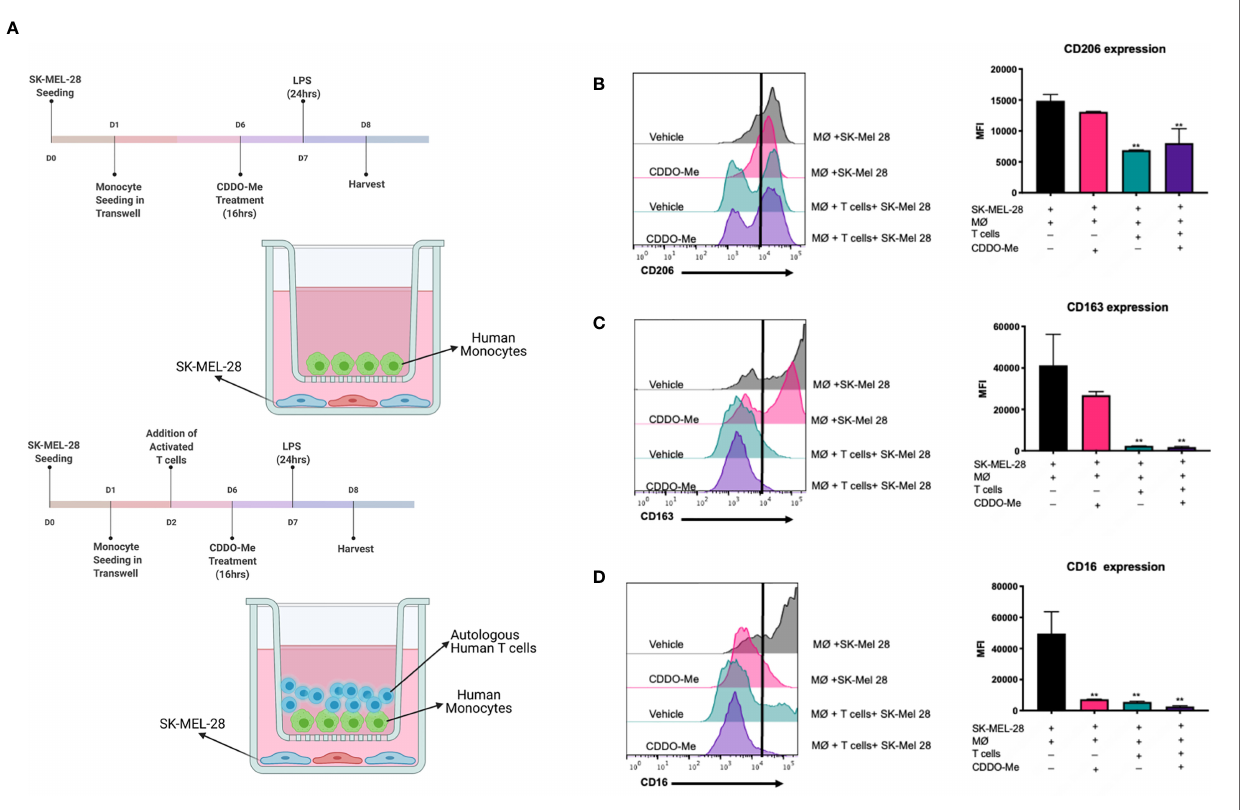
FIGURE 1 | Surface expression of markers on melanoma-conditioned macrophages is attenuated by addition of autologous T cells. Human monocytes were incubated with 20 ng/ml M-CSF and cultured with SK-MEL-28 melanoma cells in the presence or absence of autologous T cells for 5 days. Cultures were then pre-treated with 300 nM CDDO-Me or DMSO (vehicle control) for 16 h, followed by LPS stimulation (10 ng/ml) for an additional 24 hrs. (A) Diagram of culture conditions. (B) CD206, (C) CD163, and (D) CD16 macrophage (MØ) surface marker expression levels were quanti fi ed using multi-color fl ow cytometric analysis and are presented in mean fl uorescence intensity (MFI) units. Gating of positively stained cells was determined by single stained controls (negative stain control marked by black line). **p < 0.01 vs. co-culture untreated control (two-way ANOVA). Data shown are representative of results obtained from analysis of 3 individual donors and 3 separate experiments for each donor. Error bars represent standard deviation